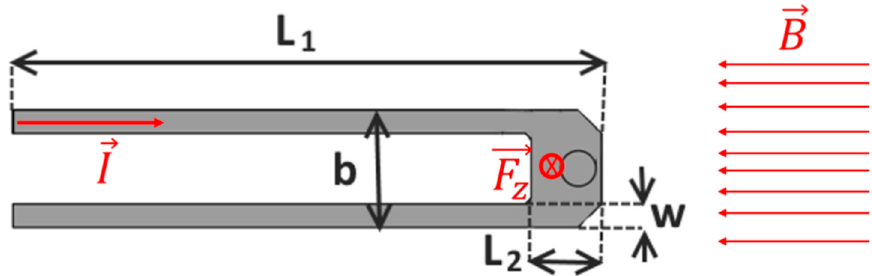
Figure 1. Design variables of the cantilever (black symbols) and schematic representation of the electromagnetic actuation by means of the Lorentz force (red lines).